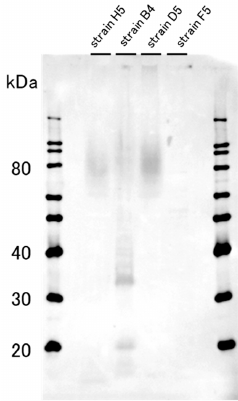
Figure 1. Western blotting results for four bacterial strains. GD1a ganglioside was detected with the anti-GD1a ganglioside antibody. Strain B4 showed two relatively clear bands at around 20 and 33 kDa and was considered as GD1a-positive. Strains H5 and D5, on the other hand, were not used in the subsequent experiments, as only smeared bands were